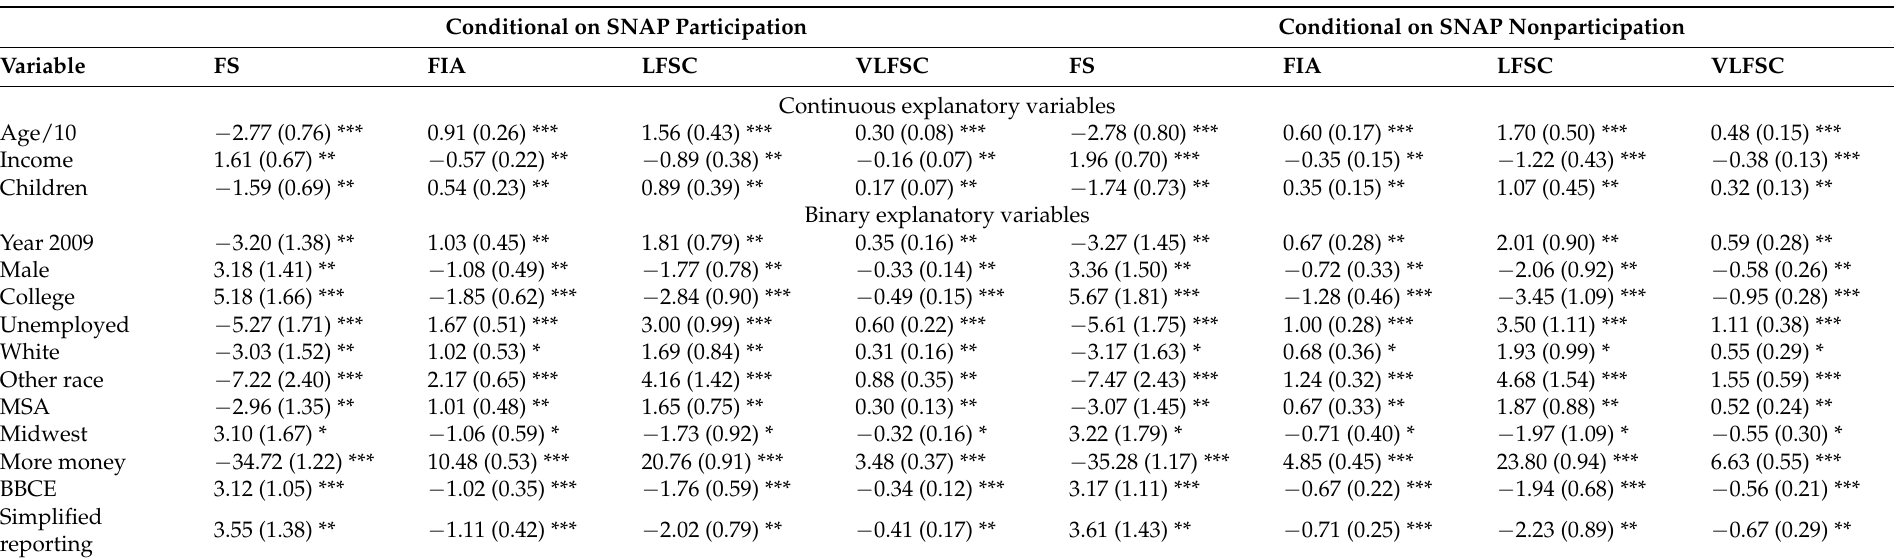
Table 4. Marginal effects of explanatory variables on the probabilities of food-insecure categories, conditional on SNAP participation status. Conditional on SNAP